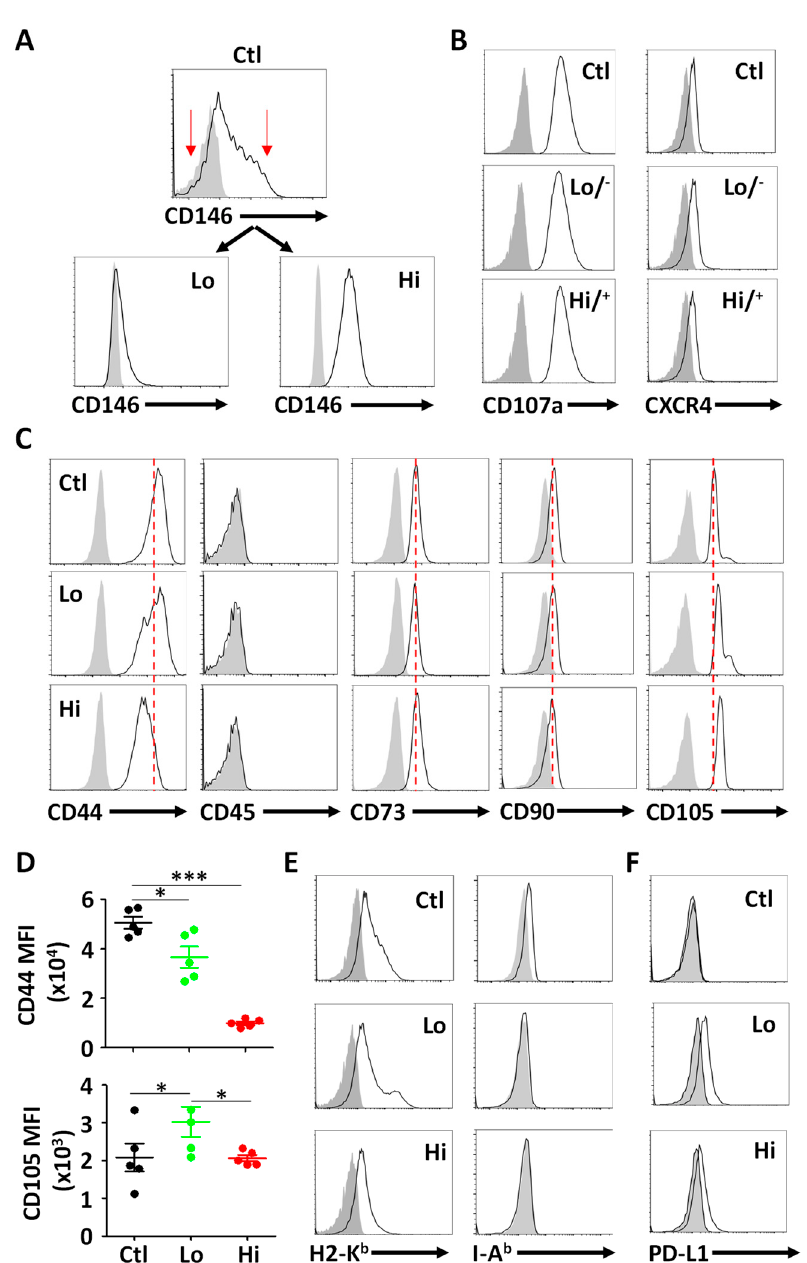
Figure 1. Isolation and phenotypic characterization of CD146 + MSCs. ( A ) Flow-cytometry analysis of CD146 lo versus CD146 hi MSCs following their sorting from the ctl parental MSC population (upper panel). ( B ) Flow-cytometry analysis of CD107a and CXCR4 expression on all three MSC populations. ( C ) Phenotypic analysis of the three different MSC populations according to ISCT guidelines. Isotype controls are shown as filled grey histograms. The red dotted line is placed according to the ctl parental MSC population. ( D ) Comparative analysis of CD44 and CD105 MFI on the different MSC populations. The ctl MSC population is displayed in black, CD146 lo MSCs in green and CD146 hi MSCs in red. ( E ) Flow-cytometry analysis of H2-K b and I-A b profiles of the three MSC populations. Isotype controls are shown in filled grey histograms. ( F ) Flow-cytometry analysis of PD-L1 profiles of the three MSC populations. Isotype controls are shown in filled grey histograms. For panel D, n = 5/group with * p < 0.05 and *** p < 0.01.